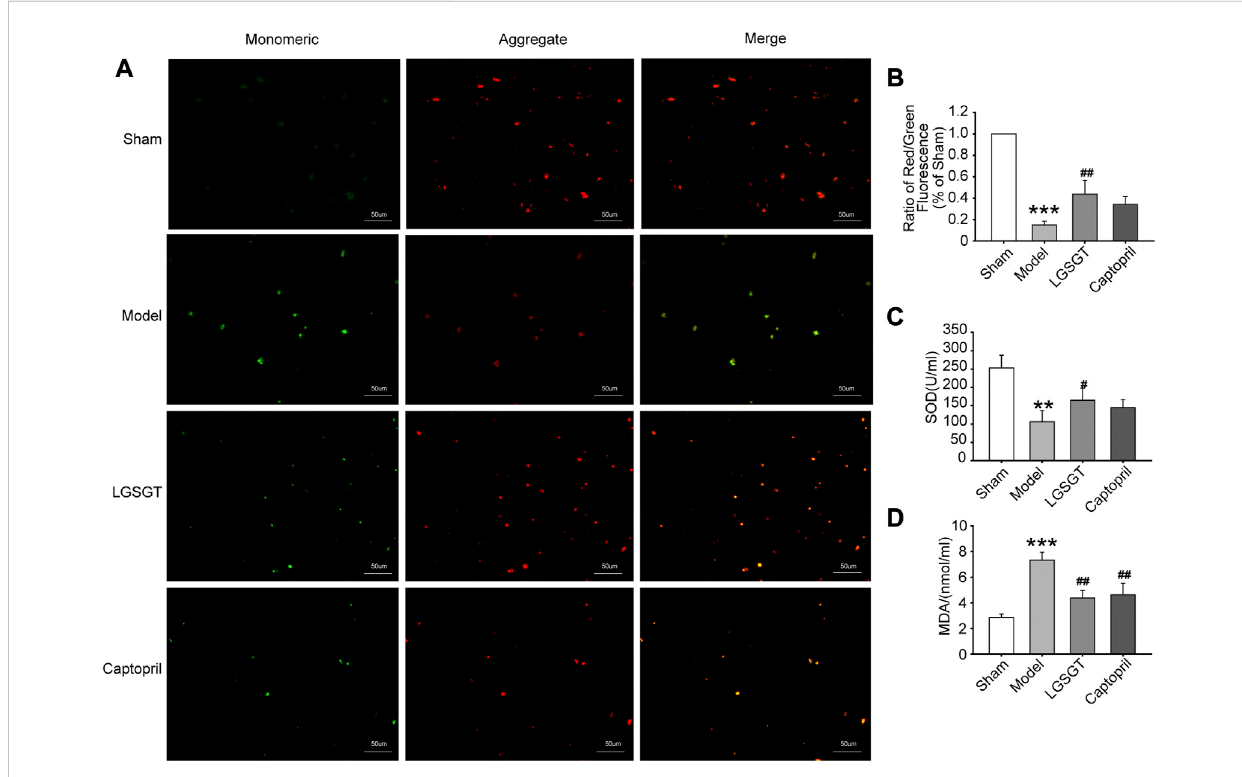
LingguiZhuganDecoctionantagonizestheoxidativestressinratswithheartfailureandreducesthemitochondrialdamageinmyocardialcells. (A,B) JC-1 staining was used to observe the effect of Linggui Zhugan Decoction on mitochondrial membrane potential levels ( n = 5). (C, D) ELISA was used to test the effect of Linggui Zhugan Decoction on serum oxidative stress indicators in rats with heart failure ( n = 7). * p < 0.05 vs. sham group; ** p < 0.01